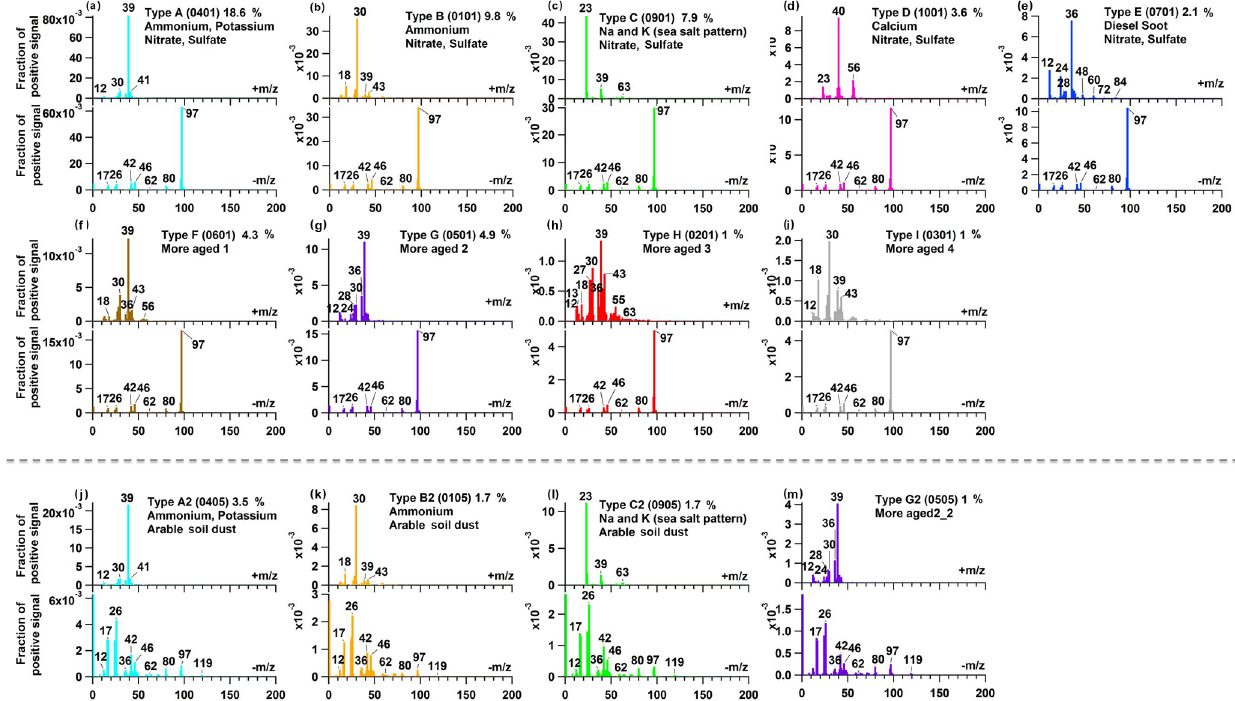
Figure 10. Mass spectra for 13 different types of particles measured on 29 July 2016 during the field campaign TRAM01, based on the classification according to laboratory-based reference spectra. The four-digit codes in the brackets represent particle types (refer to Table S2). The percent values are the particle number fractions. For (a) to (e) and (j) to (l) , there are two lines for the names; the first and second lines correspond to the highly correlated positive and negative references,